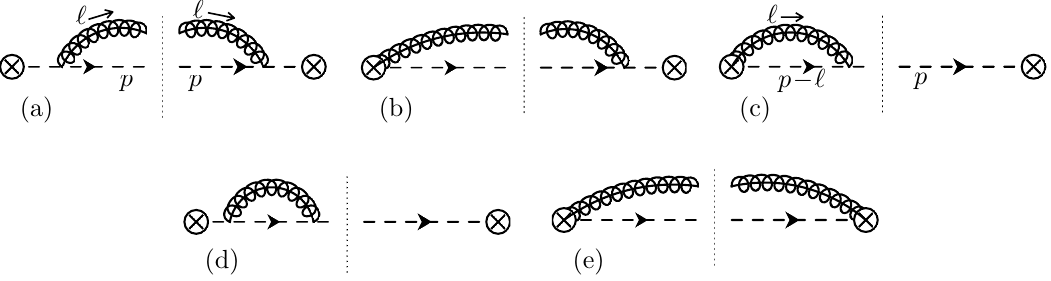
Figure 2 . Diagrams contributing to the angularity jet function at one-loop order. Here, p µ is the quark momentum and l µ is the gluon momentum. The mirror image graphs for (b), (c) and (d) are not shown here. Diagram (d) denotes the quark wave-function renormalization